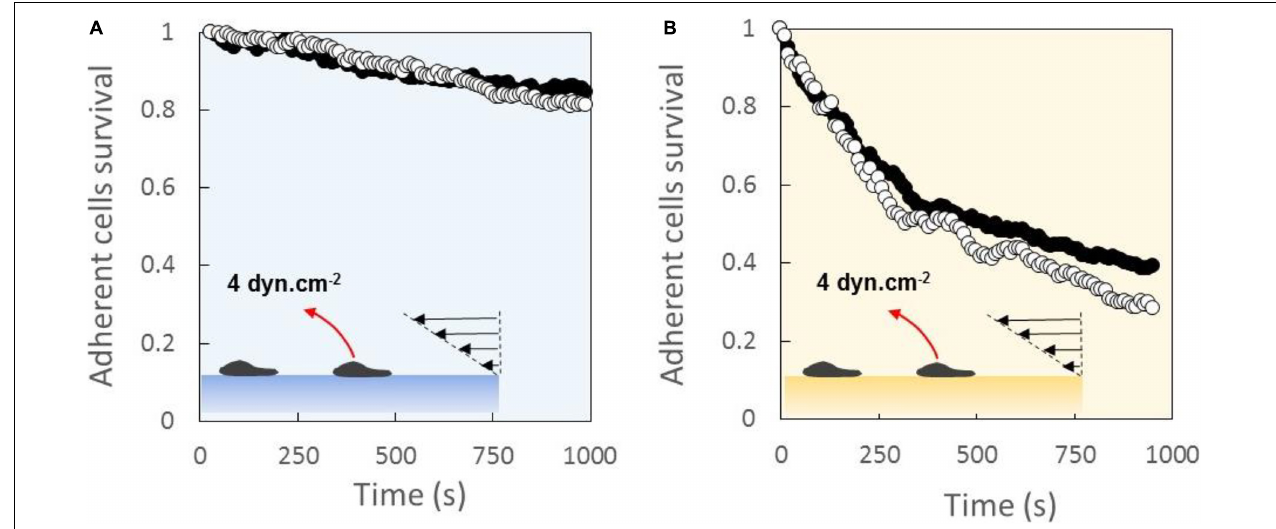
FIGURE 2 | Laminar flow chamber experiments of global adhesion yield stronger binding with LFA-1 than with VLA-4. Survival versus time of cell bonds with a substrate coated with 1000 molecules. µ m − 2 (black dots) or 600 molecules. µ m − 2 (white dots) of ICAM-1 (A) and VCAM-1 (B) . Shear stress of 4 dyn/cm 2 was continuous applied. Nexp = 3. N cells per experiment =